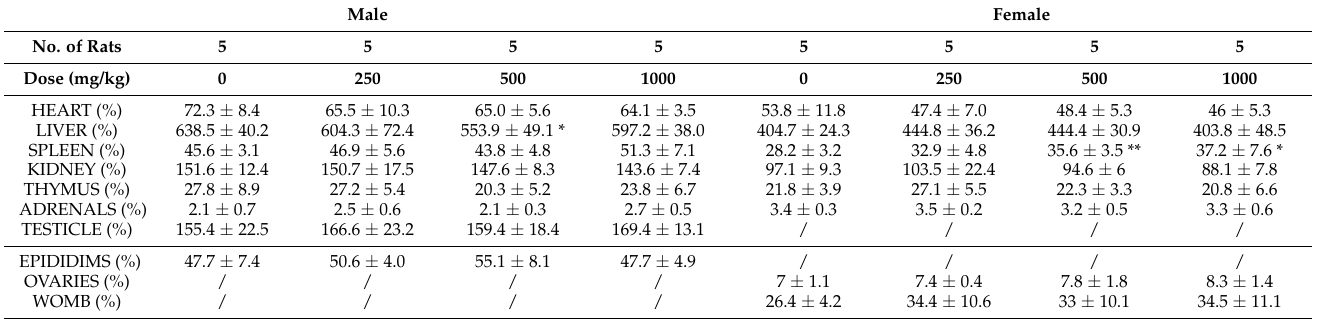
Table 5. Relative organ weight/brain weight of male and female rats fed with 0, 250, 500,